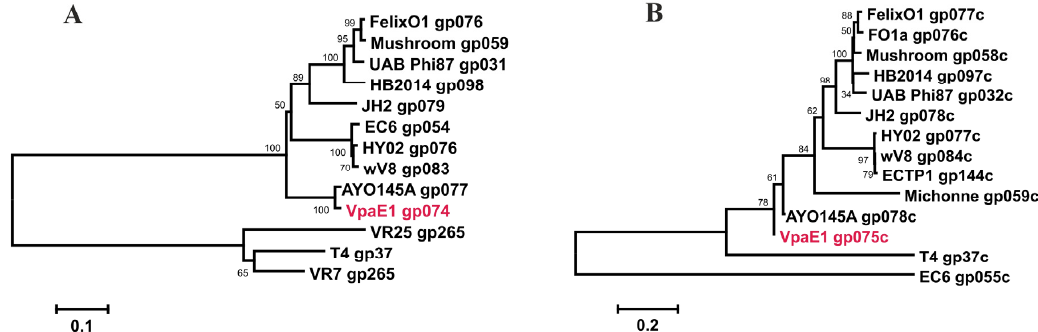
Figure 9. Phylogenetic analysis. Neighbor-joining trees were constructed based on the amino acid sequence alignment of VpaE1_gp74 ( A ) and VpaE1_gp75C ( B ) with tail fiber proteins from various myoviruses. The numbers at the nodes indicate the bootstrap probabilities.